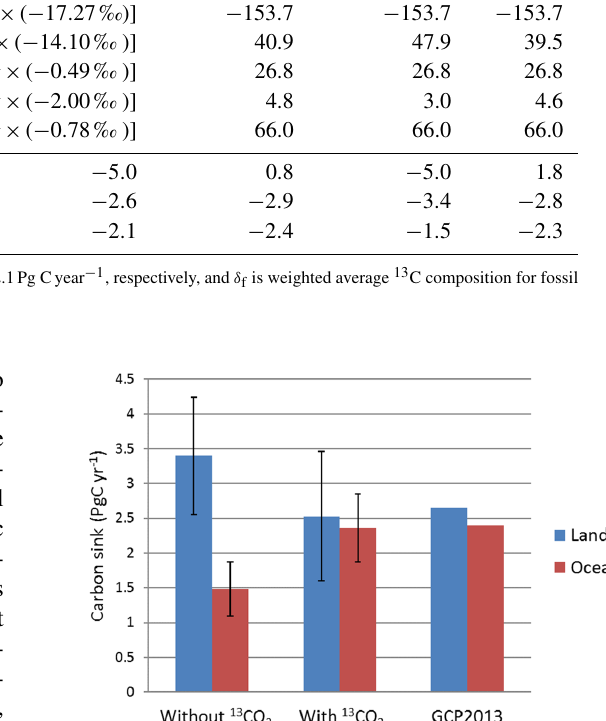
ence in the discrimination rate between land and ocean. In